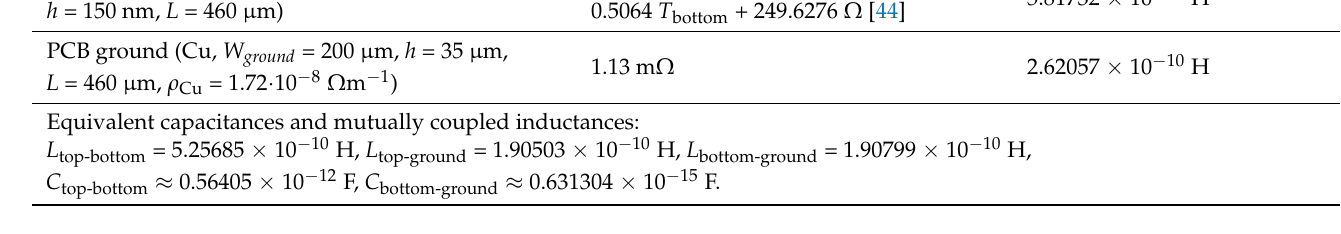
Table 2. The equivalent resistance and inductance of transmission line for low frequencies up to 1 MHz. Conductor Equivalent Resistance Equivalent Inductance Top resistor (Pt, W top = 2.75 µ m., h = 150 nm, 155 Ω at 20 ◦ C L = 460 µ m) Bottom resistor (Pt, W bottom = 4.96 mm., h = 150 nm, L = 460 µ